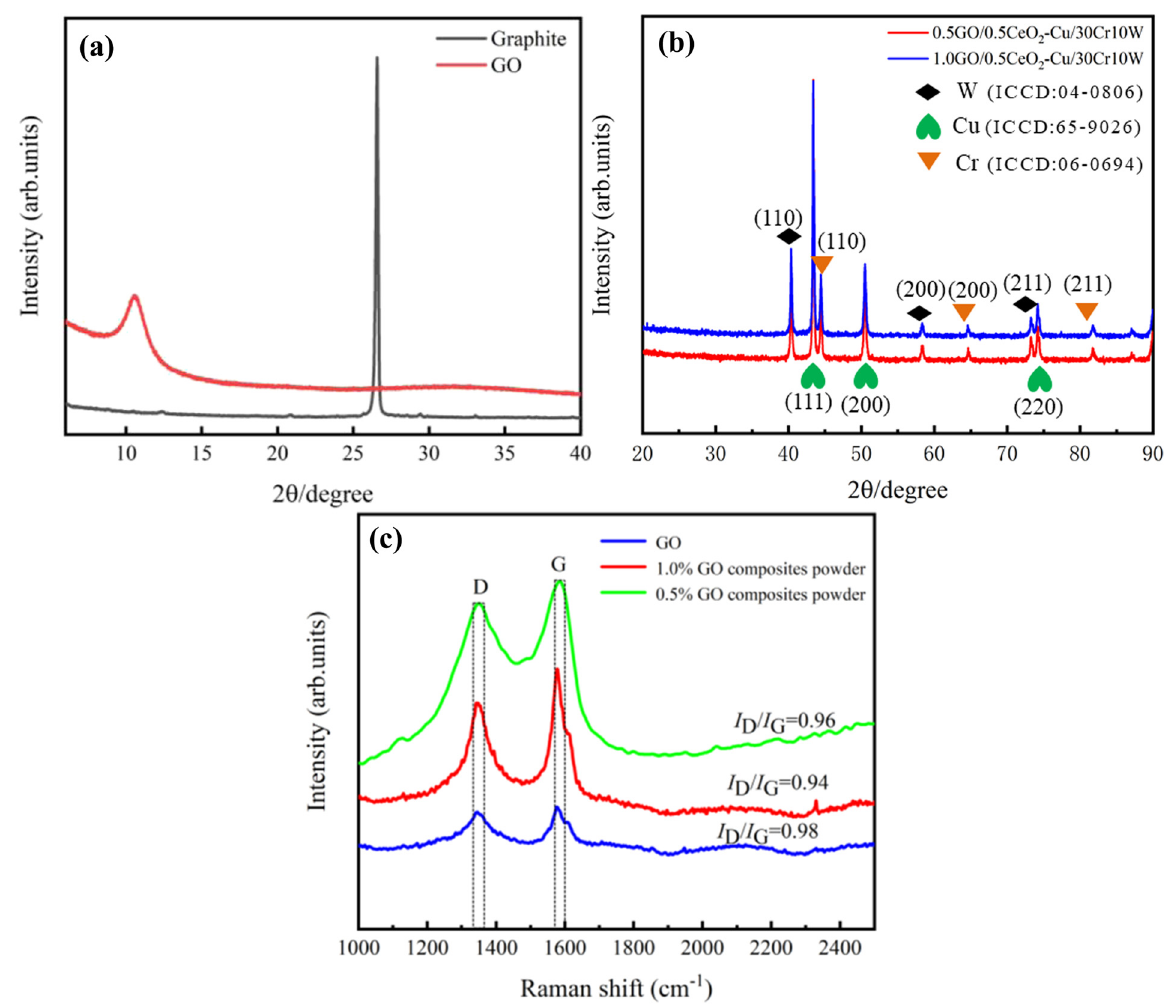
Figure 2: ( a ) XRD patterns of GO and graphite and ( b and c ) XRD and Raman patterns of the composites